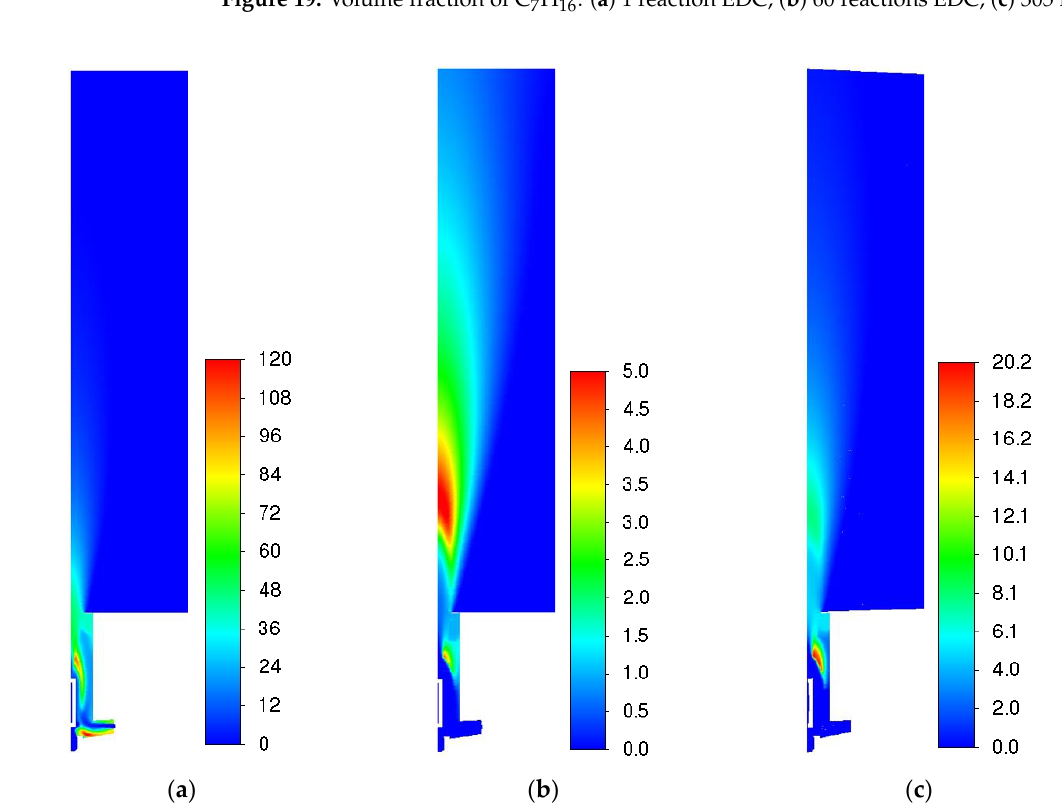
Figure 20. Concentration of NO x : ( a ) 1 reaction EDC; ( b ) 60 reactions EDC; ( c ) 305 reactions EDC